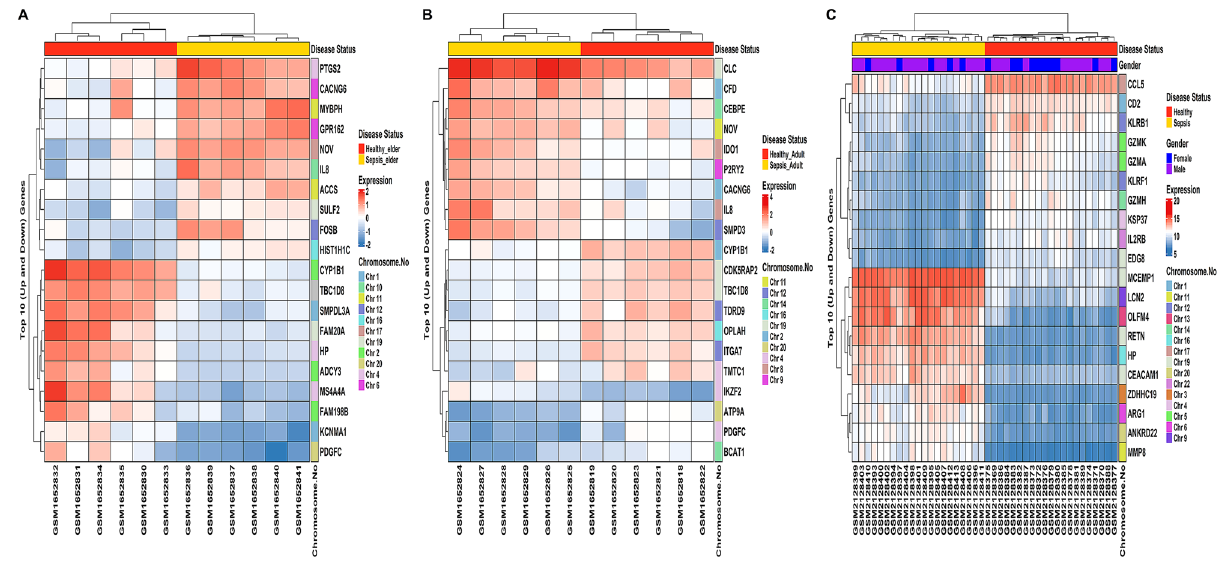
Figure 1. Heatmap of top 10 down and upregulated sepsis-specific DEGs in (A) elder (GSE67652), (B) adult (GSE67652), and (C) children (GSE80496) age groups. The expression of DEGs (within rows) is normalized across all the samples (within columns). The cluster dendrograms indicating hierarchical clustering (Euclidean distance-based) for both columns and rows are exhibited along the top and left sides of the plot. The gender type annotation bar (only for children age groups) and sample type annotation bar (for all age groups) are placed at the top of heatmaps. The position of genes on their respective chromosome number is shown as a vertical annotation bar (multicolor bands) in the right panel.